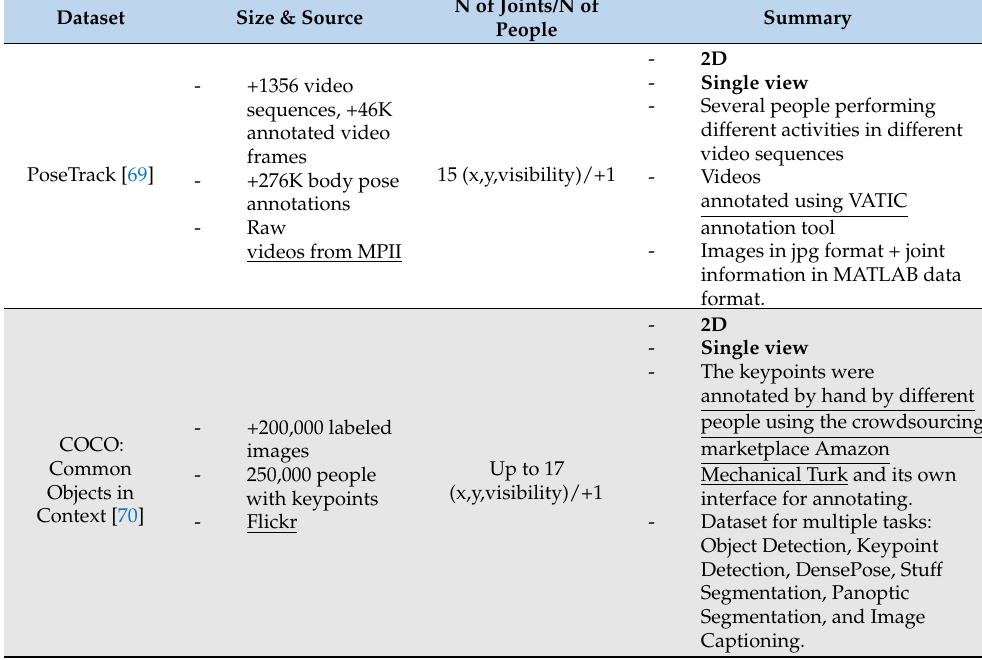
Table A3. Alternative HPE Evaluation Datasets applied in SPE by several